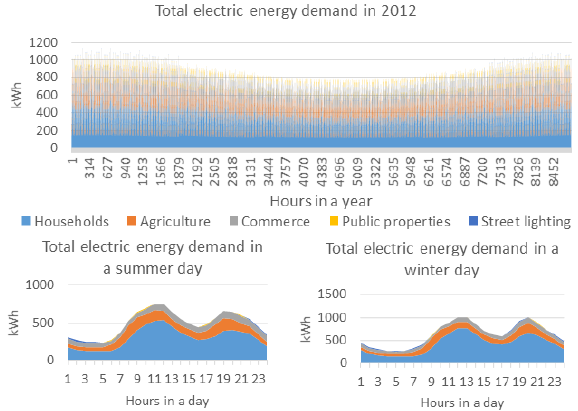
Figure 2. Cumulated energy demand of all user types in one hour time step for